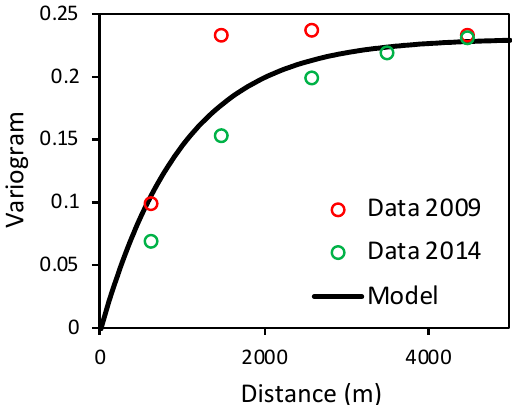
Figure 5. Empirical variogram of the stochastic residual of the water quality index and fitted exponential variogram model.